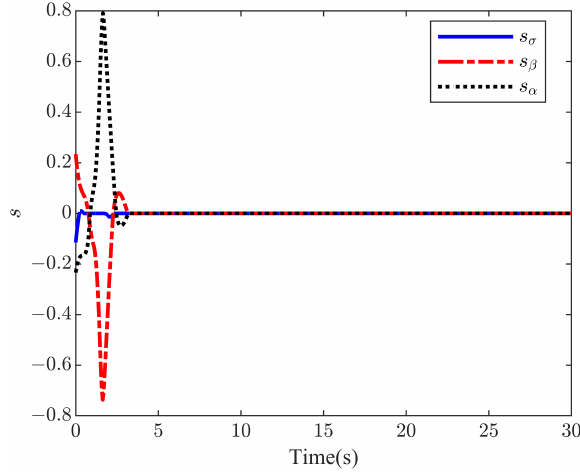
Figure 7. Time histories of the sliding manifolds.